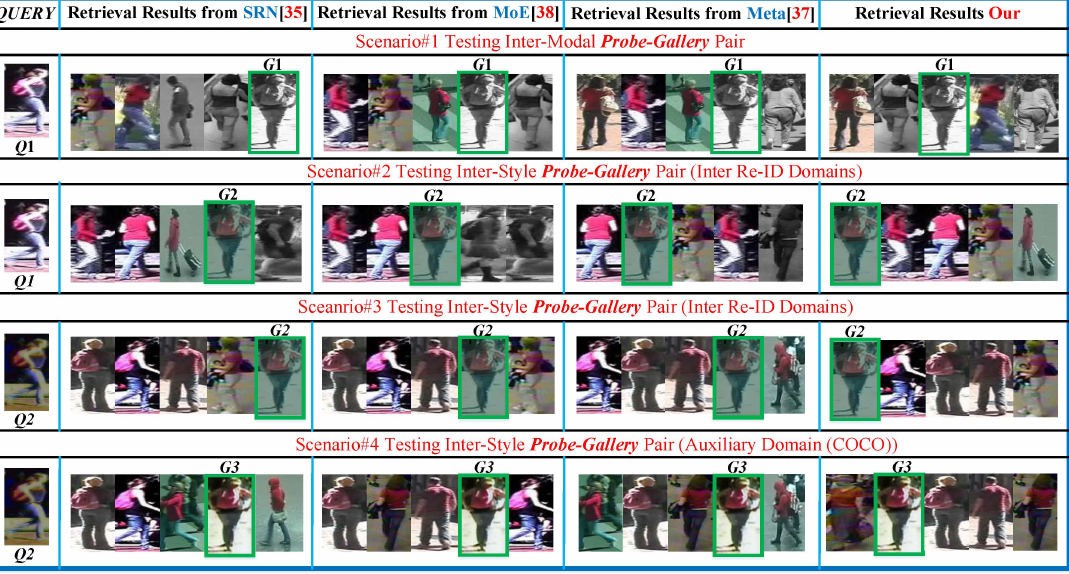
Figure 18. Retrieval results of Our M G , SRN [35], Meta [37], and MoE [38] in real-world scenarios. Green Rectangles contain correct matches.